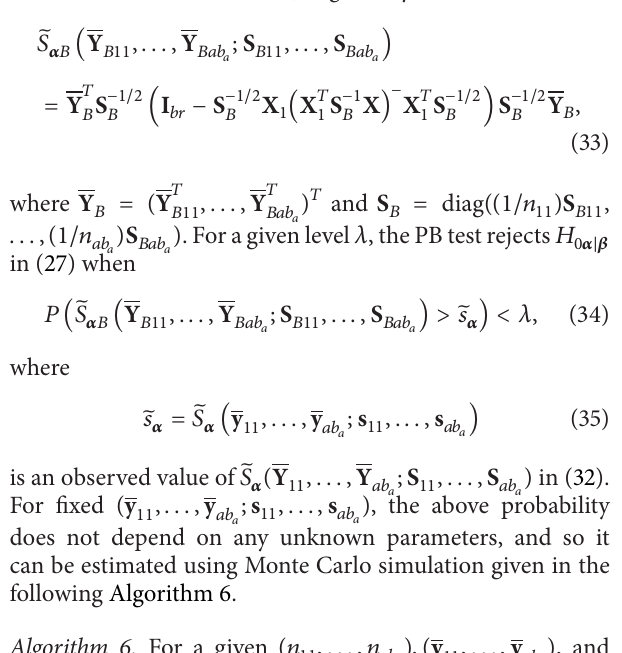
Algorithm 6. For a given (𝑛 11 , . . . , 𝑛 𝑎𝑏